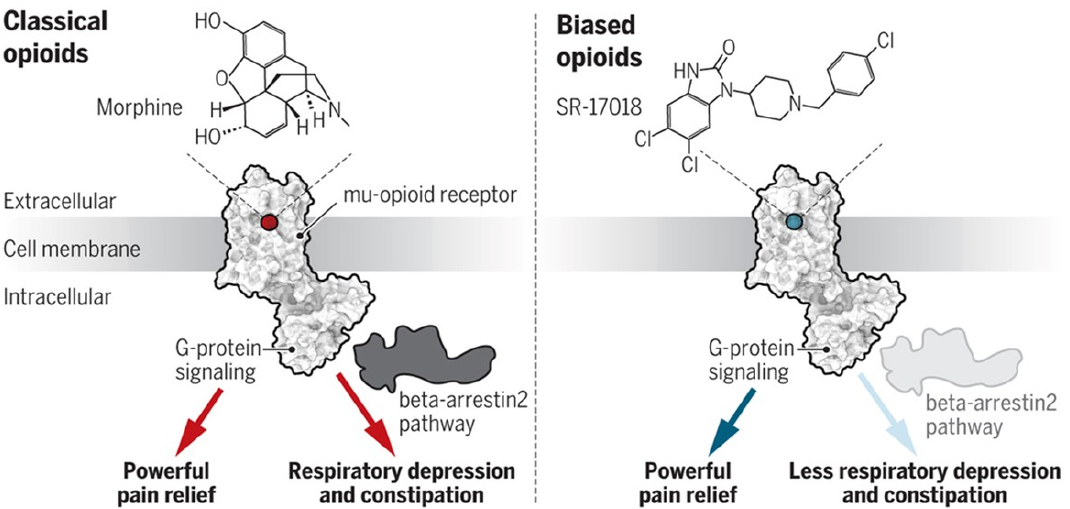
Figure 6. Classical Opioids vs. Biased Opioids. Classical opioids transmit both the beneficial and the harmful side effects. Biased opioids transmit only the beneficial effects. Reproduced with permission from Servick, K., Science ; published by American Association for the Advancement of Science, 2020 [33].